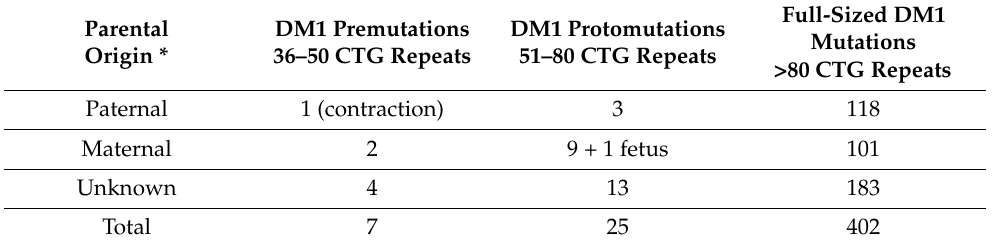
Table 2. Premutations, protomutations, and full-sized mutations detected in subjects referred for DM1.